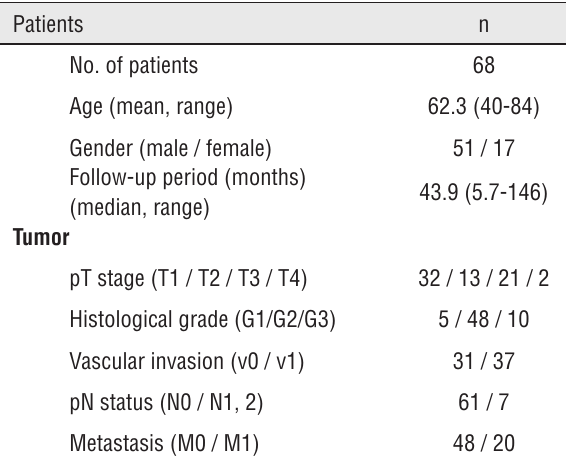
Table 1 - Patient and tumor characteristics.